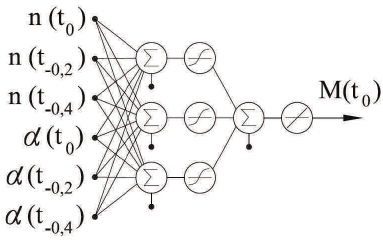
Fig. 5. ANN architecture that ensures best data approximation